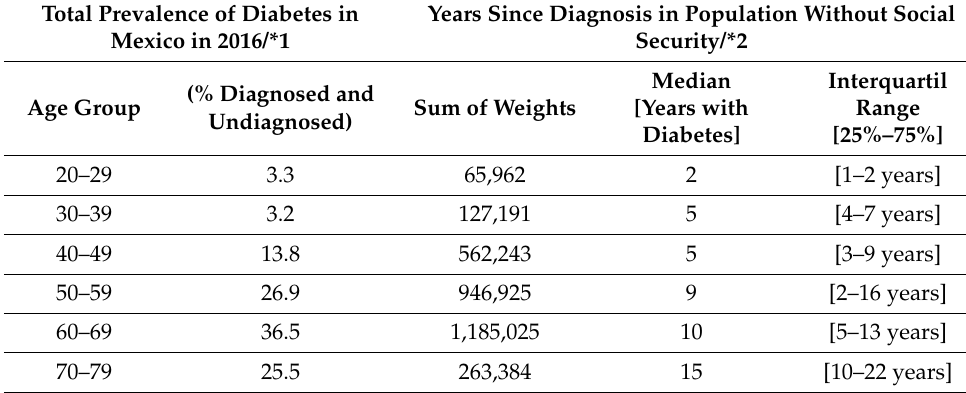
Table 1. Type 2 diabetes prevalence and years since diagnosis.